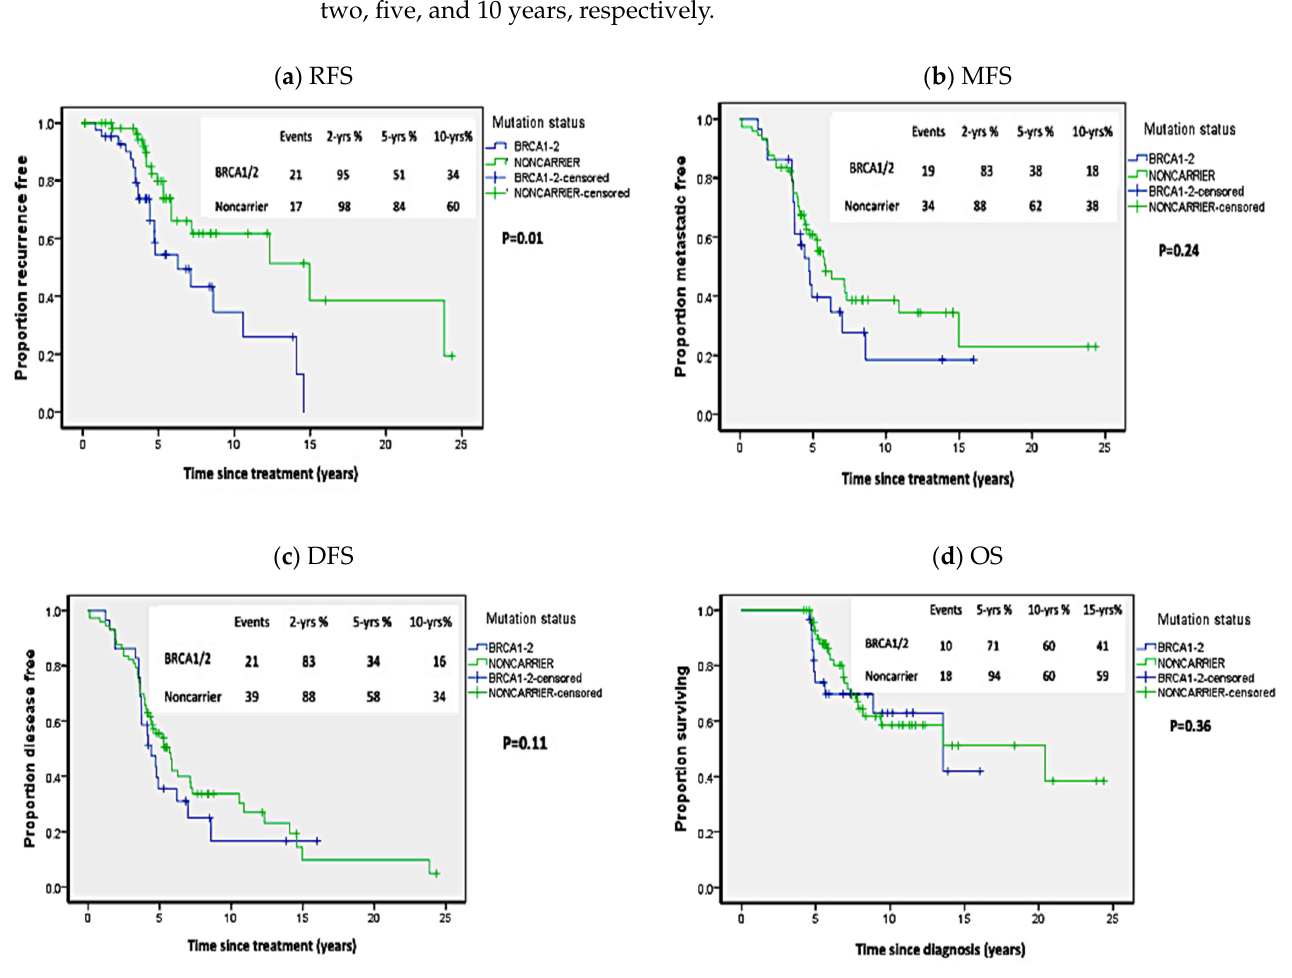
Figure 1. Kaplan Meier plots of survival analysis in carriers of BRCA1/2 pathogenic mutations and non-carriers. ( a ) Recurrence-free survival (RFS), ( b ) Metastasis-free survival (MFS), ( c ) Disease-free survival (DFS), ( d ) Overall survival (OS). p -values calculated by log-rank test (considering whole follow-up period).